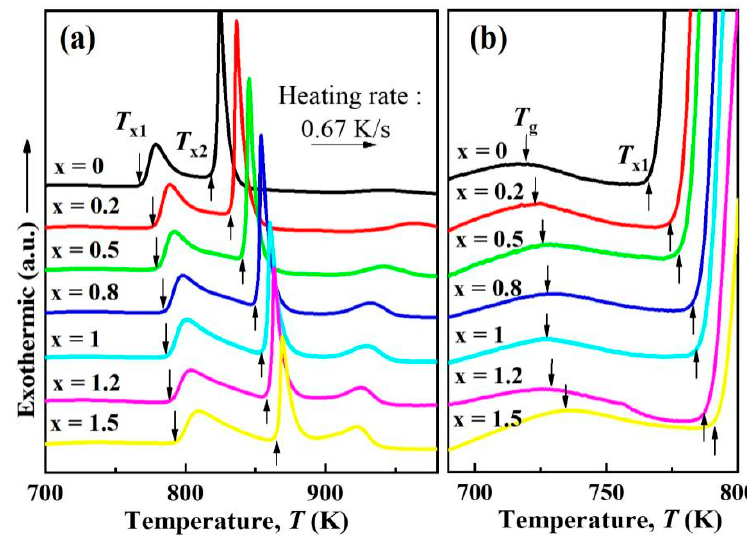
Figure 2. ( a ) DSC curves of the as-cast (Fe 0.76 Si 0.09 B 0.1 P 0.05 ) 99.3 − x Nb x Cu 0.7 ( x = 0, 0.2, 0.5, 0.8, 1.0, 1.2, 1.5) ribbons heated at a rate of 0.67 K/s. ( b ) Enlarged DSC curves showing the supercooled liquid region.